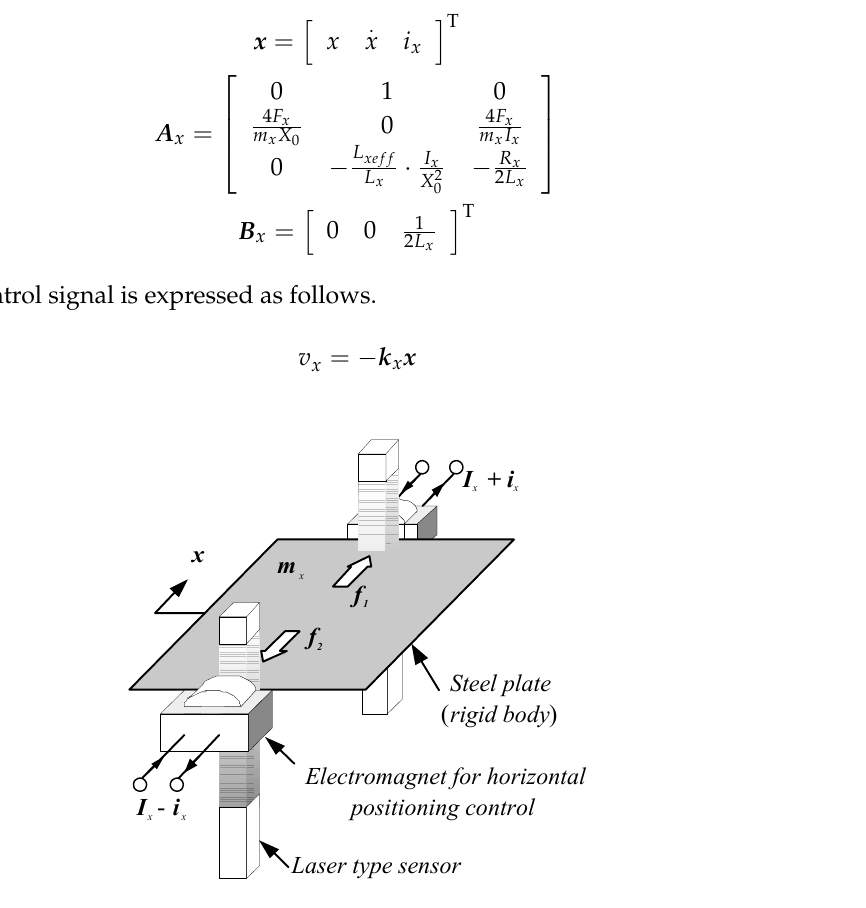
Figure 4. Theoretical model of the horizontal positioning control of the steel plate.